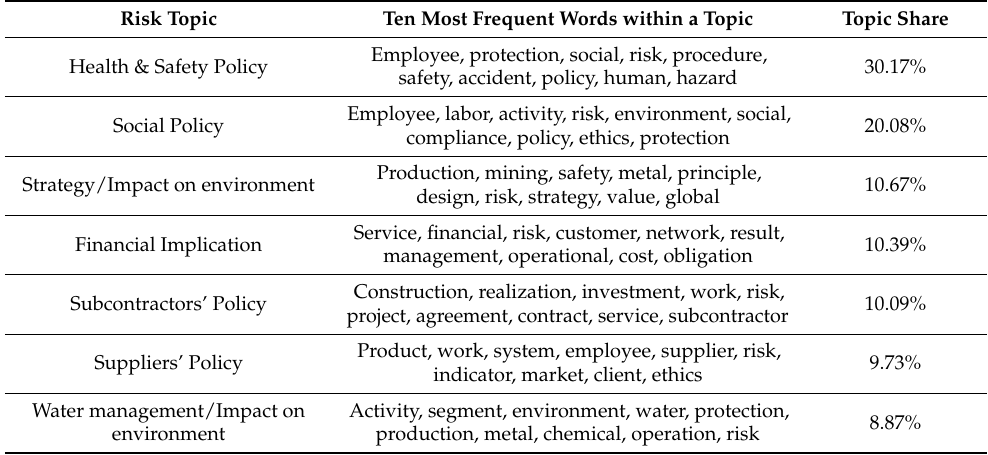
Table 2. Risk topics with ten most frequent words and topic share.